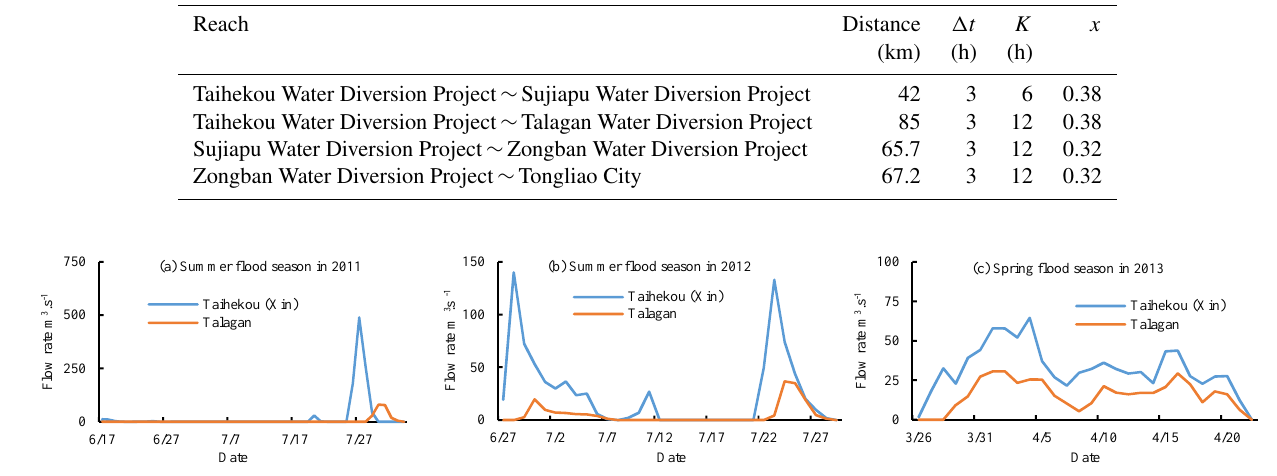
Figure 4. The comparison of daily flow rate of Taihekou (Xin) station and Talagan